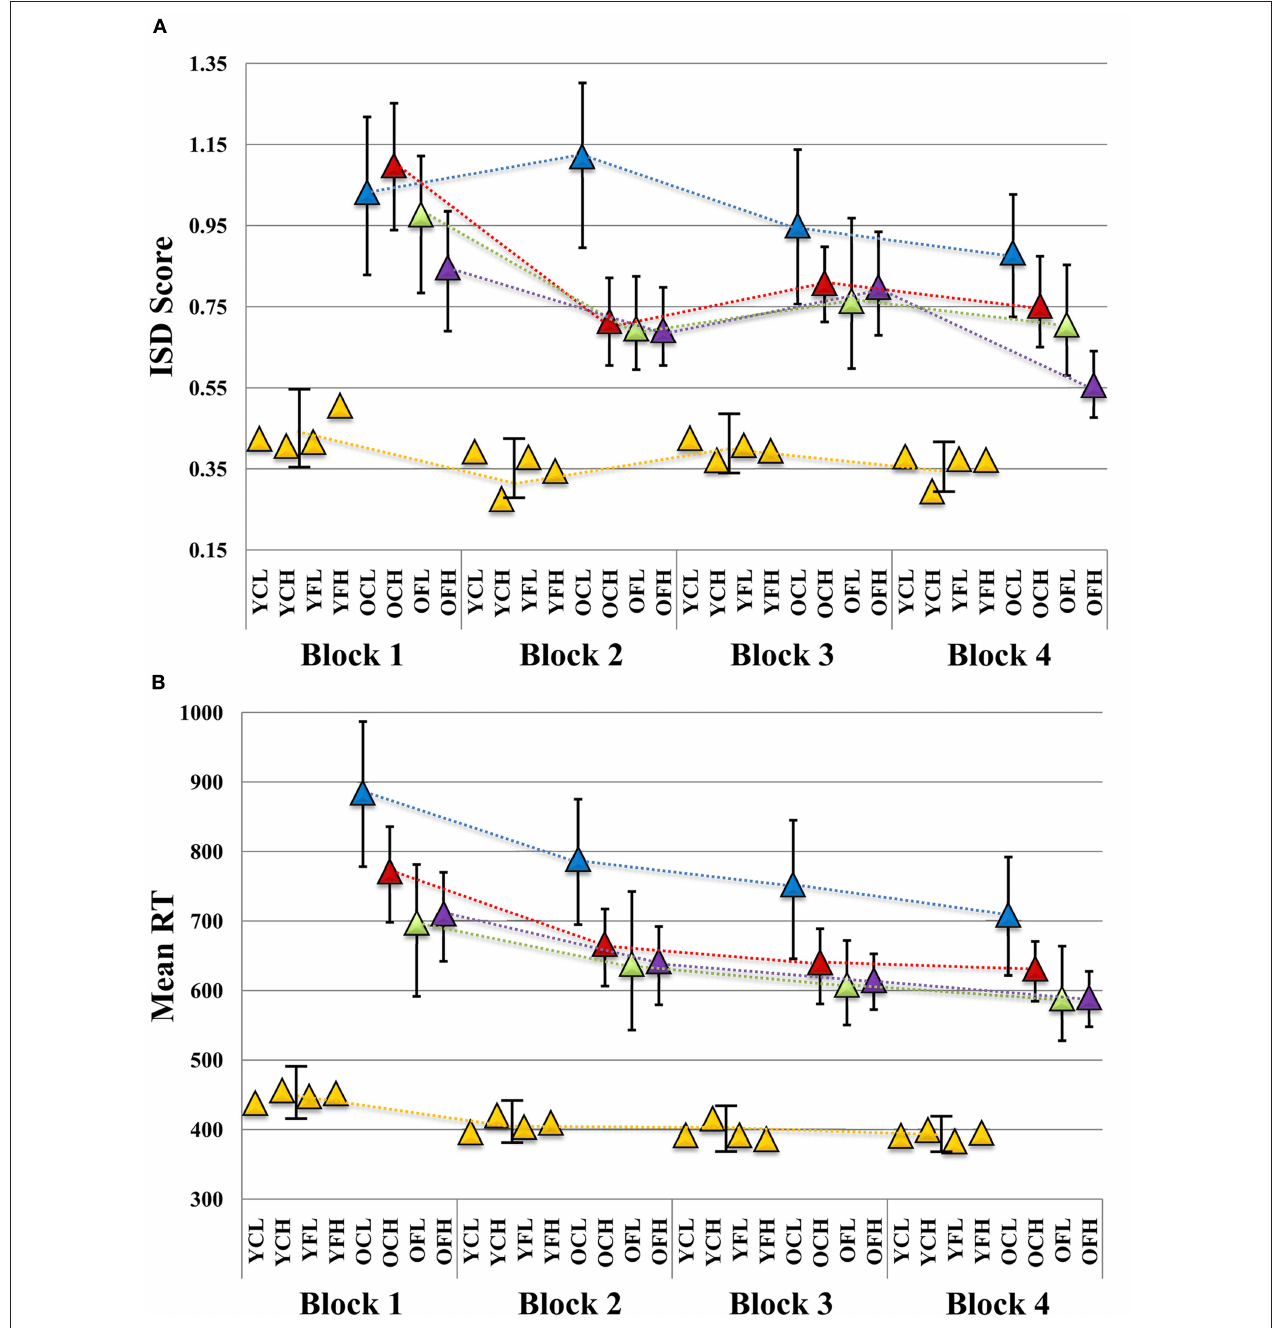
FIGURE 2 | Plot of block-wise (A) ISD and (B) mean RT results in relation to age, feedback, and education level. ISD, intraindividual standard deviation; YCL, younger, control, lower education; YCH, younger, control, higher education; YFL, younger, feedback, lower education; YFH, younger, feedback, higher education; OCL, older, control, lower education; OCH, older, control, higher education; OFL, older, feedback, lower education; OFH, older, feedback, higher education. All slopes were plotted according to Aiken and West’s (1991) method. Using betas for each block (including all main effects and interaction terms), point estimates were determined while evaluating education at + 1 SD (17.64 years) and − 1 SD (13.42 years) from the